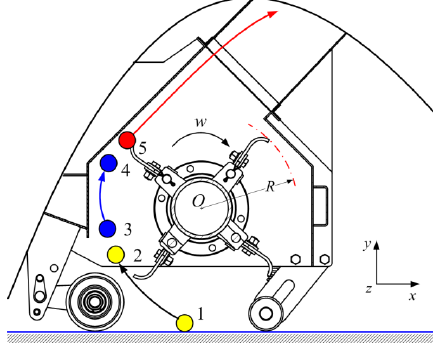
Figure 3. Removal process of light impurity.